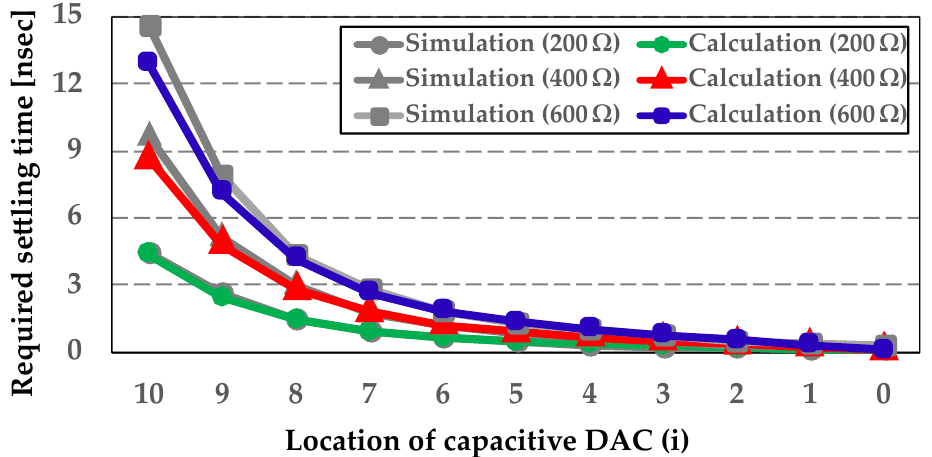
Figure 10. Calculation and simulation result of required settling time according to R ref and location of capacitive